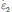
Schematic and illustration of the constitutive model.A: Rheological representation of the viscoelastic model, where the material consists of parallel chains, and each chain consists of an elastic component (denoted by a spring) and a viscous component (denoted by a dashpot). Usually, the steady-state response of a viscoelastic solid is represented by a chain with no viscous component (i.e., τ = ∞). Here, in addition to one solid chain, models including one and two chains with viscous components are evaluated and denoted as one-term and two-term models. B: Illustration of how stimuli with a low strain-rate may lose information from low time-constant QLV chains. The solid line is the response of a typical two-term viscoelastic solid with time constants τ
1 and τ
2 under a step load. Two dashed lines represent the response of the material under slower strain-rates. For the slowest strain-rate, ε˙2, stress relaxation properties of the faster chain (τ
1) may not show up because its relaxation for the faster chain takes place within its ramp phase. Therefore, this will not be captured by curve fitting, which simply characterizes the material as a one-term QLV solid and only calculates the slower chain (with time constant τ
2). Thus, we can eliminate the two extra parameters (G
1, τ
1) if we only care about low strain-rate situations. In other words, for low strain-rate cases, the single term model is sufficient and therefore more appropriate than the two-term models because of the reduced number of free parameters.